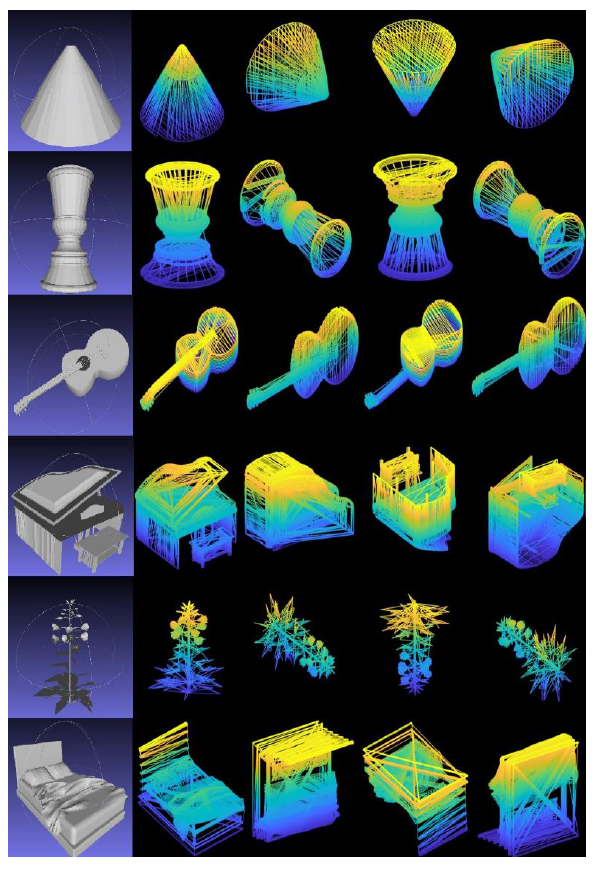
Figure 7. The Random models and four 2D projections of Point Clouds from the dataset: ModelNet40.